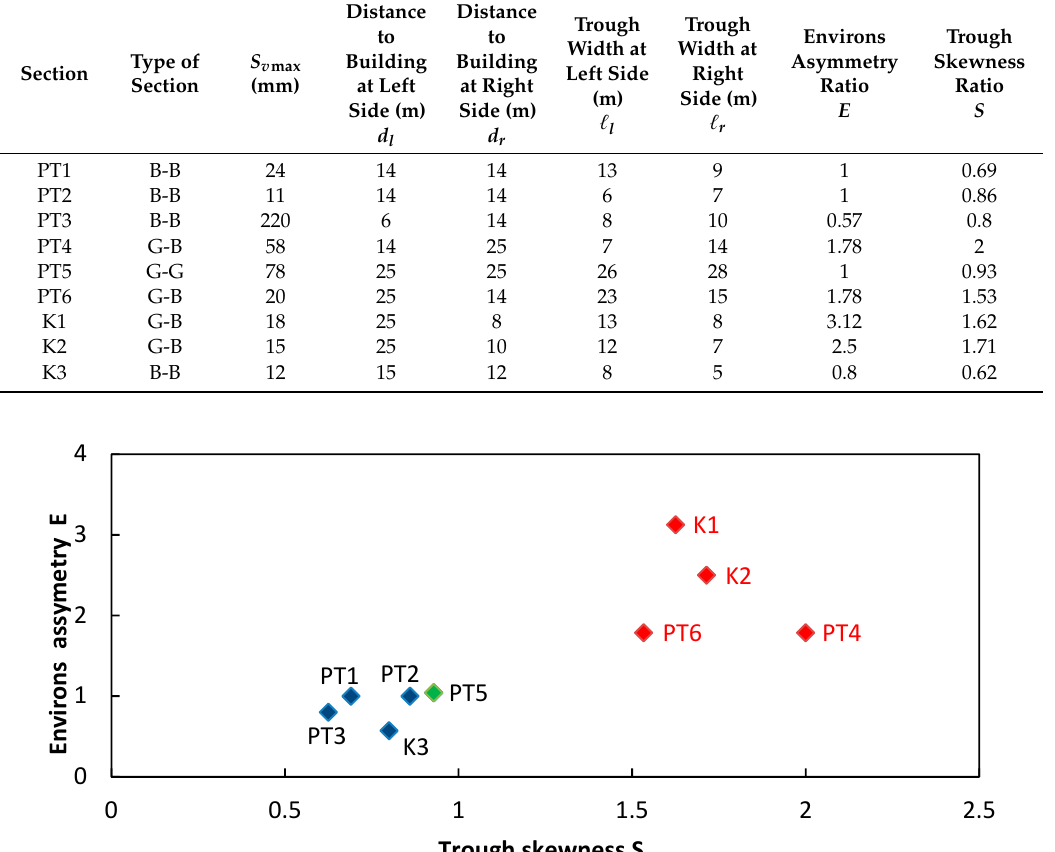
Figure 10. Environs asymmetry ratio E (distance to buildings) as a function of the subsidence trough skewness ratio S . Data as in Table 2. Skewness ratio S is minimum in uniform greenfield areas (PT5, in green) and maximum in sections with buildings at one side of the tunnel axis (Building-Greenfield, i.e., PT4, PT6, K1, K2 shown in red).